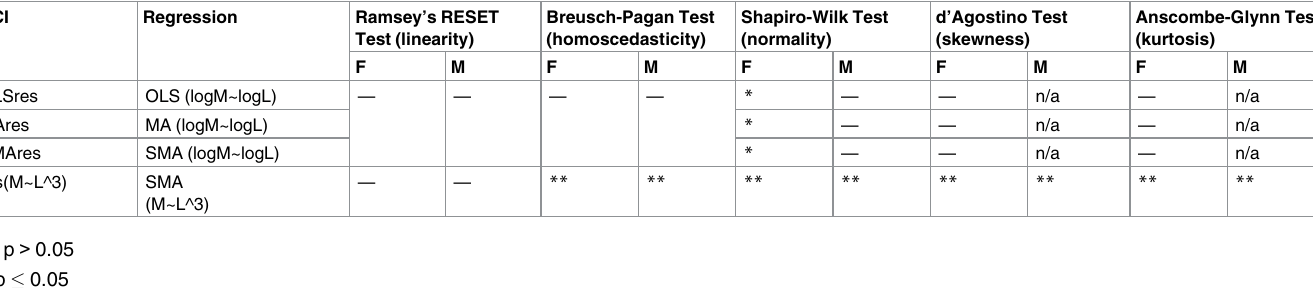
Table 4. Tests of assumptions of the regression-based body condition indices (BCIs). We used several tests to test the hypotheses that: 1) the data are linear; 2) the variance is constant (i.e., homoscedastic); and 3) the frequency distribution of residualsis normal. For clarity, only p-values are reported. Most assumptions are met for regressions of log-transformed mass on log-transformed length, but regressionsof mass on length cubedexhibitedneither homoscedasticity nor normality. Abbreviations for each of the BCIs are providedin Table 1.